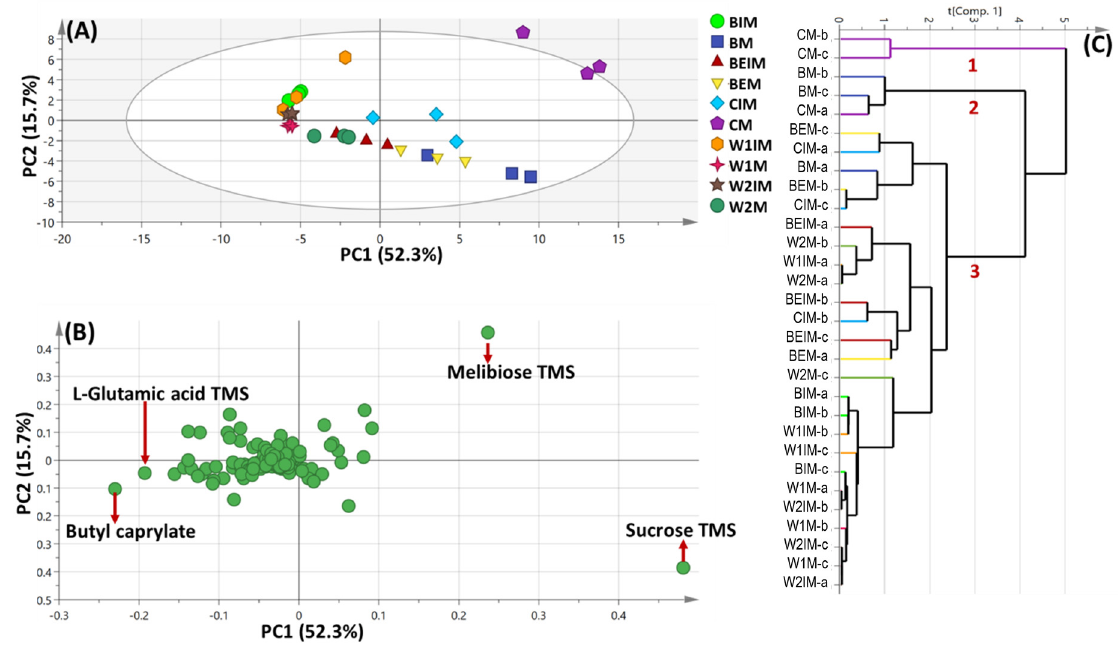
Figure 2. GC/MS-based unsupervised principal component analyses (PCA) and hierarchical clustering (HCA) of metabolites analyzed in whole sample dataset. ( A ) PCA score plot of PC1 against PC2. ( B ) Loading plot for PC1 and PC2, with contributing primary metabolites and their assignments. The metabolome clusters are located at the distinct positions in two-dimensional space described by two vectors of principal component 1 (PC1) = 52.3% and PC2 = 15.7%. ( C ) HCA plot showing 3 main subdivisions.